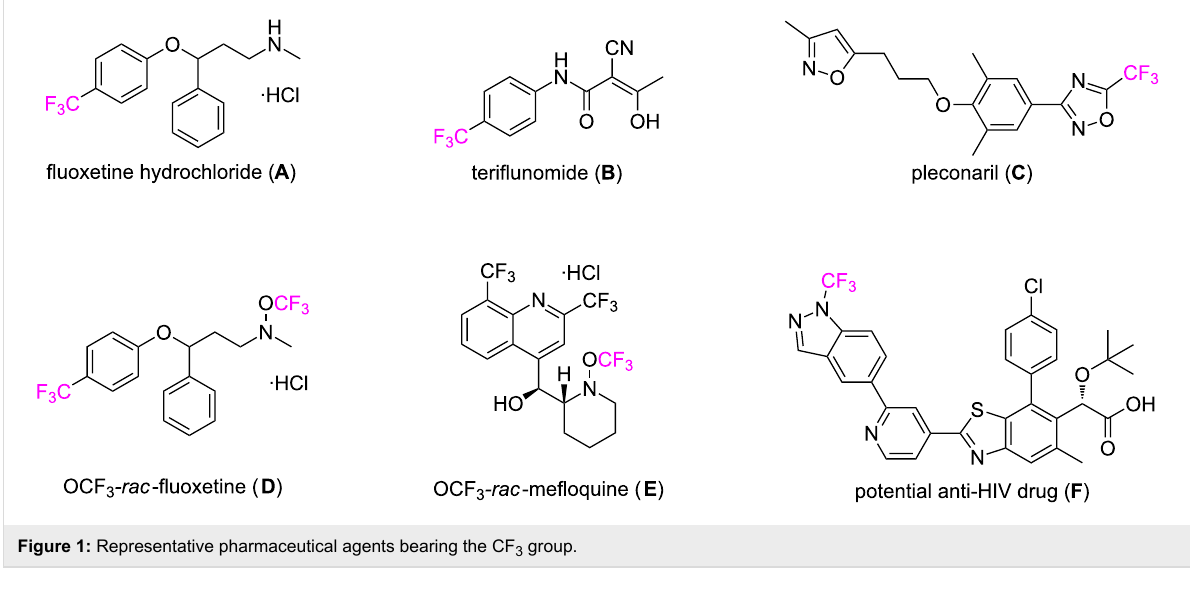
group into various organic molecules, the further development continuing interest for synthetic and medicinal chemists.